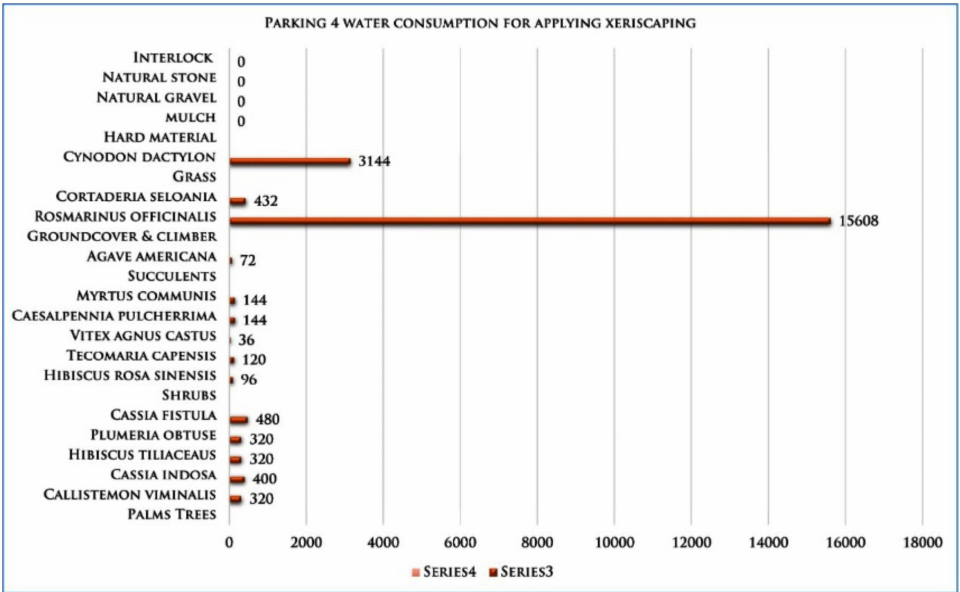
Figure 16. Experiment 2 water consumption quantity after applying xeriscaping items. Xeriscaping softscape design water consumption (Details in Table